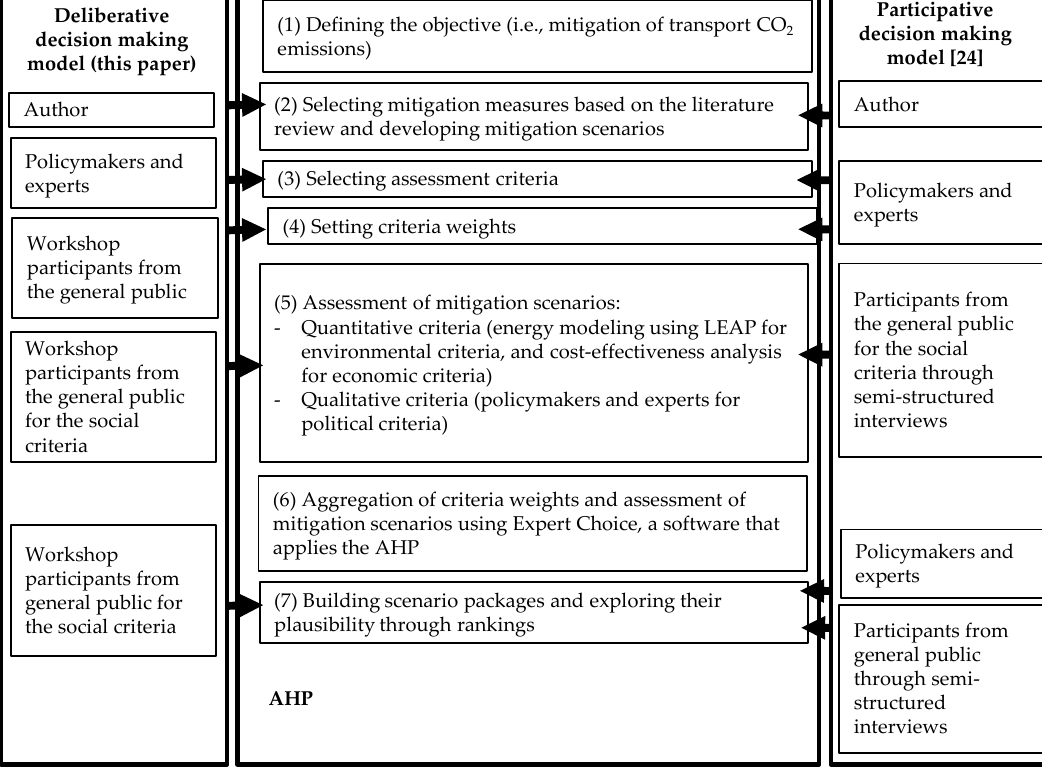
Figure 1. Overview of the applied methodology. N otes: CO 2 = carbon dioxide; AHP = Analytic Hierarchy Process; LEAP = Long Range Energy Alternatives Planning System.